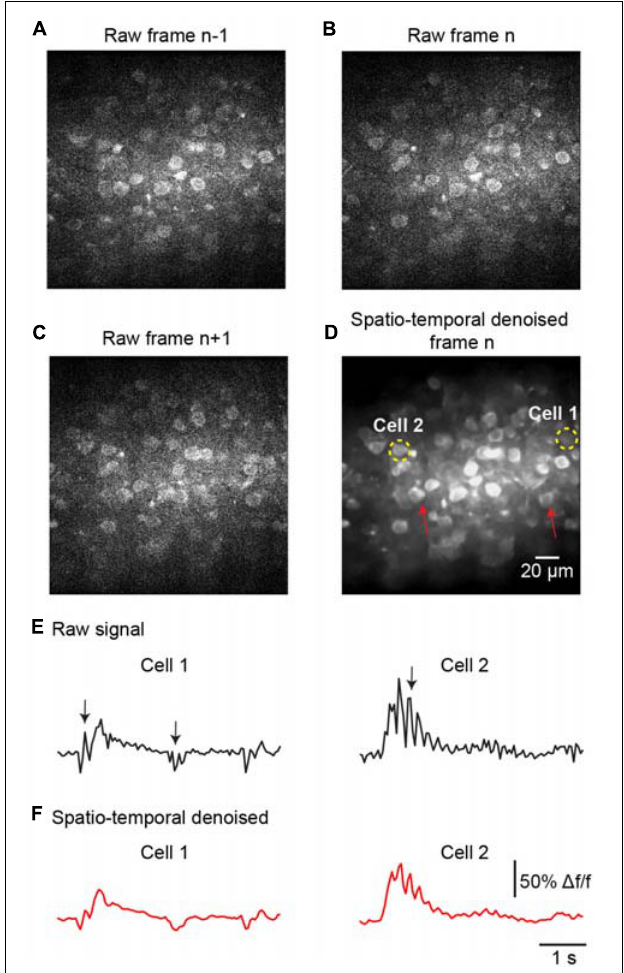
FIGURE 5 | Denoising performance evaluation for temporal inconsistency. A stack of two-photon imaging data: (A) frame n-1 , (B) frame n , and (C) frame n + 1. Restored images using (D) the proposed model blind spatiotemporal filtering method: PSNR 31.27/SSIM 0.87. The red arrows indicate the inconsistent areas due to motion changes. The yellow dashed circles indicate the ROIs for the cells. (E) The raw Ca 2 + signals extracted from the cells in (D) . (F) The extracted Ca 2 + signals were processed by model blind spatiotemporal filtering.